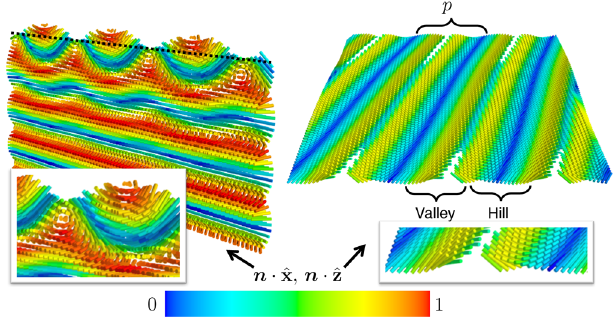
FIG. 9. Interface undulations at an isotropic-CLC interface. We simulate an isotropic-CLC interface in a slab geometry ( 24 × 24 nm in the x and y directions and 18 nm wide in the vertical direction) by tuning our Landau – de Gennes potential to the coexistence point, which corresponds to constants A ¼ 5 . 2311 , B ¼ − 11 . 2612 , and C ¼ 0 . 8889 . In this case, the CLC and isotropic phases are equally favored energetically. We plot just the CLC region, showing the local orientation of the molecules according to the Q tensor. By starting with an initial condition that is isotropic on the top of the slab and a uniform CLC on the bottom, we make an interface where the two regions initially meet in the middle of the slab. The anchoring conditions are strongly planar on the bottom of the slab (to force the pitch to align along the z axis in the bulk of the slab) and free on the top. There are periodic boundary conditions in the x and y